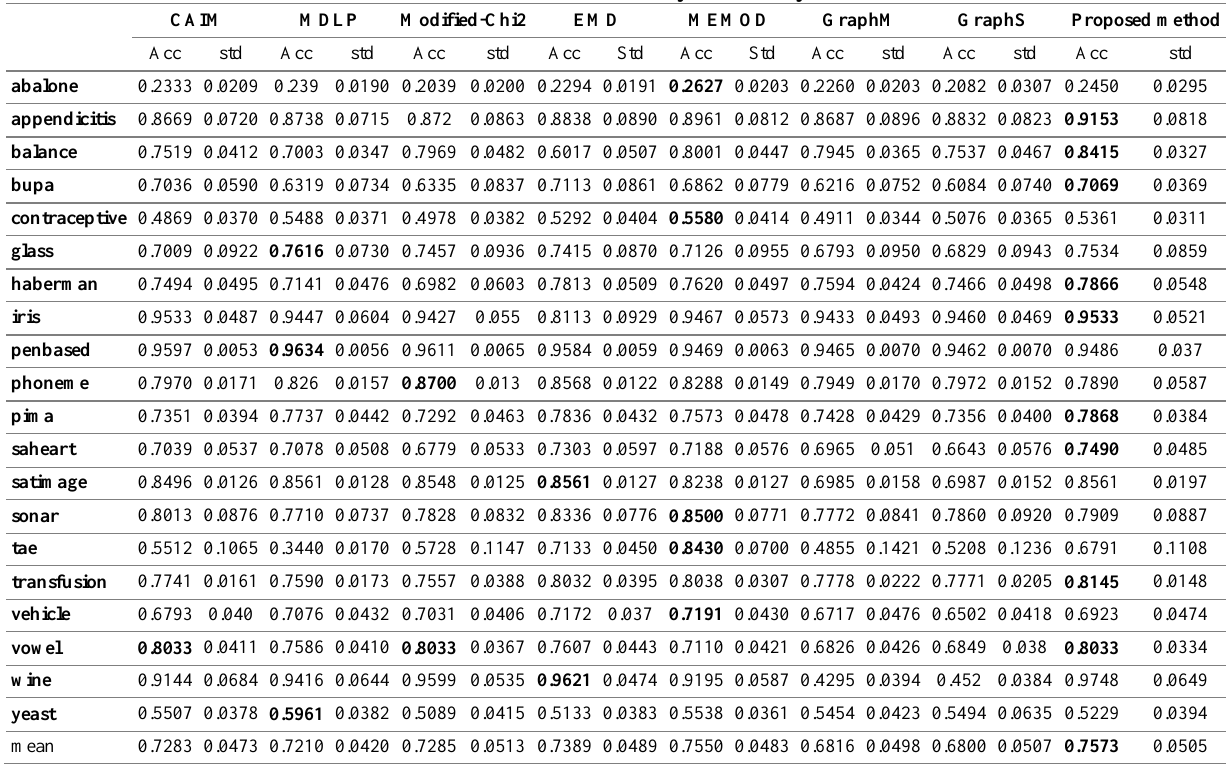
Table 7. The classification accuracy obtained by